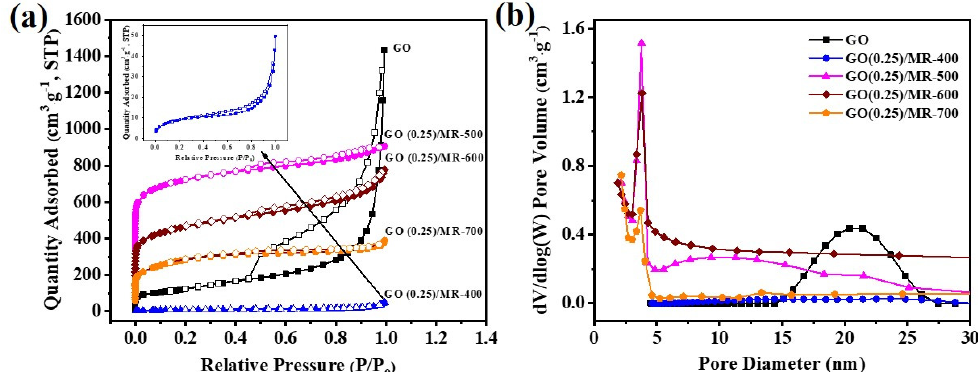
Figure 2. ( a ) N 2 adsorption-desorption isotherms and ( b ) pore size distributions of GO and GO(0.25)/MR-derived nitrogen-rich porous carbon materials obtained at different activation tem- perature.